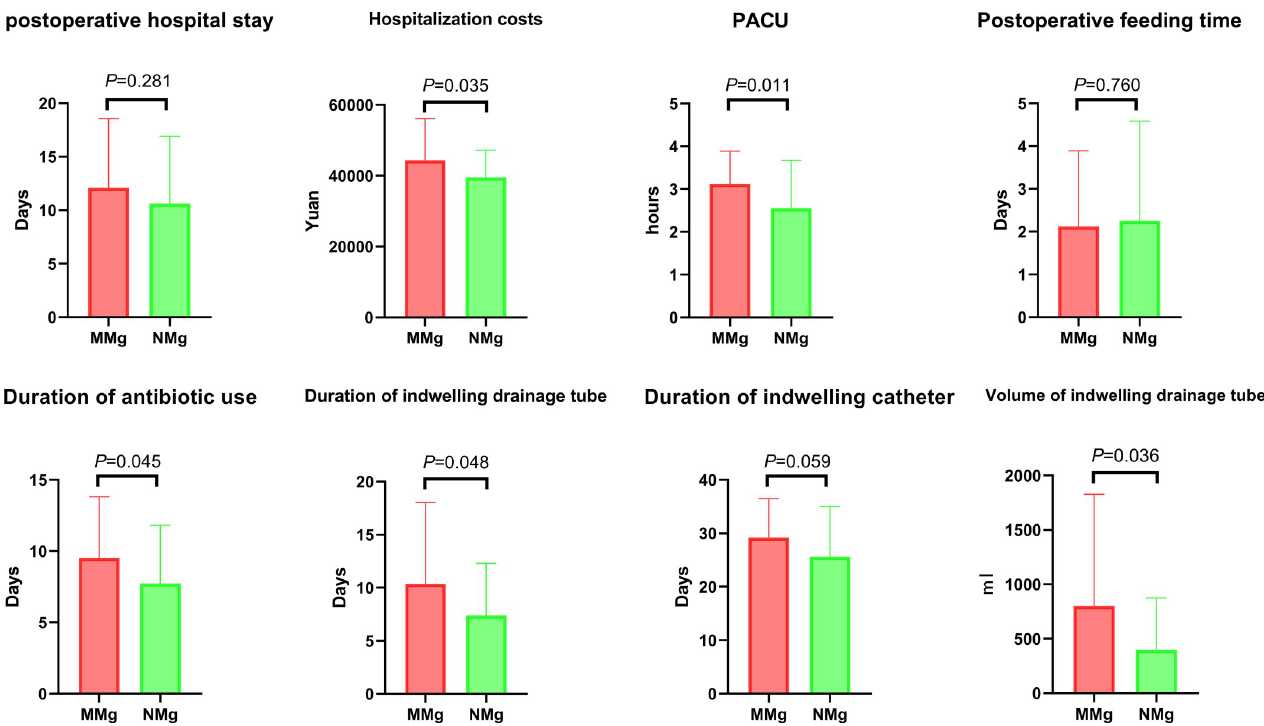
Fig 2. Comparison of postoperative recovery characteristics between the two